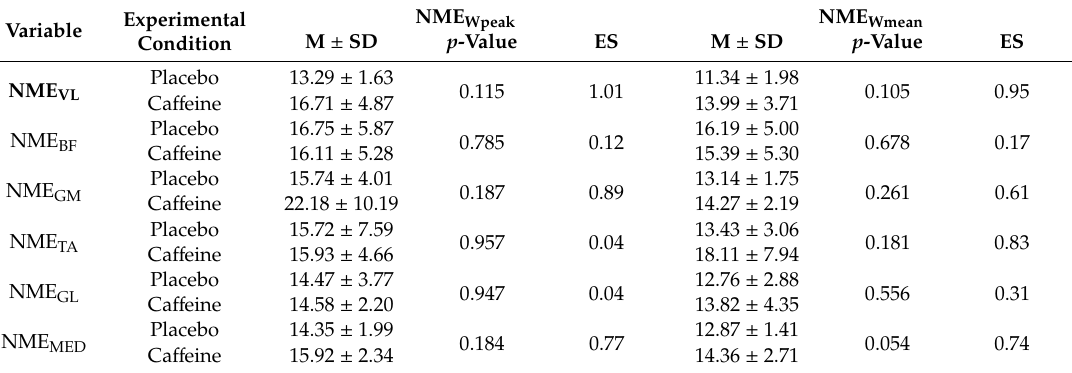
NME Wpeak : ratio between W peak and EMG Wpeak ; NME Wmean : ratio between W mean and EMG Wmean ; NME VL : neuromuscular e ffi ciency measured on the vastus lateralis; NME BF : neuromuscular e ffi ciency measured on the biceps femoris; NME GM : neuromuscular e ffi ciency measured on the gluteus maximus; NME GL : neuromuscular e ffi ciency measured on the gastrocnemius lateral head; NME TA : neuromuscular e ffi ciency measured on the tibialis anterior; NME MED : neuromuscular e ffi ciency measured as the mean values of the five muscles analyzed; * Significant di ff erence between Placebo and Ca ff eine condition at p <